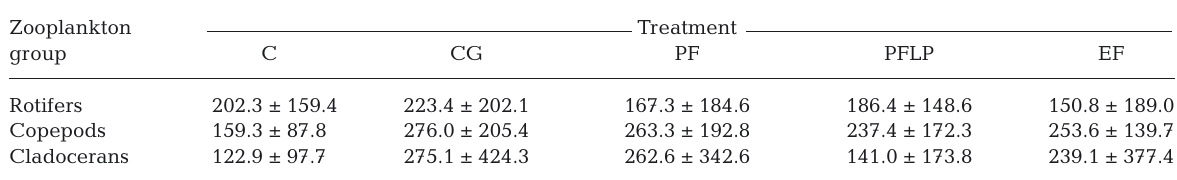
Table 3. Mean (±SD) density (ind. l −1 ) of the main zooplankton groups in each treatment (see Table 2)